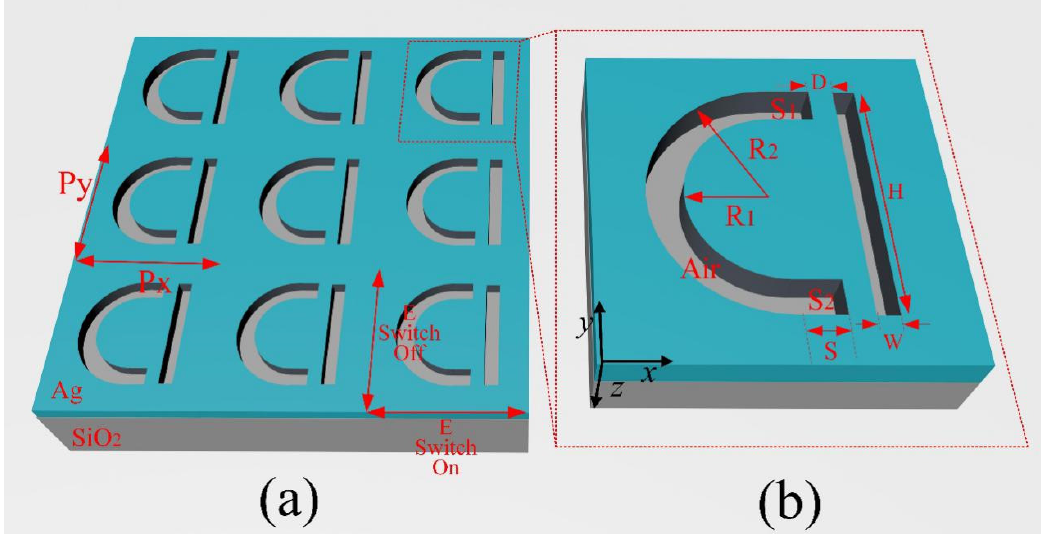
Figure 1. ( a ) Cross-sectional diagrams of the periodic hoof-shaped structure arrays. ( b ) Structural cross-sectional diagram of the unit structure in the X-Y plane. R 1 represents the U-shaped inner radius, R 2 represents the U-shaped outer radius; W and H are the width and length of rectangle; D is the distance between two geometric shapes; S is the length of the U-shaped tip. As follows: R 1 = 100 nm; R 2 = 200 nm; W = 50 nm; H = 400 nm; S = 50 nm; D = 50 nm; P x = P y = 600 nm; The incident light propagates in -Z